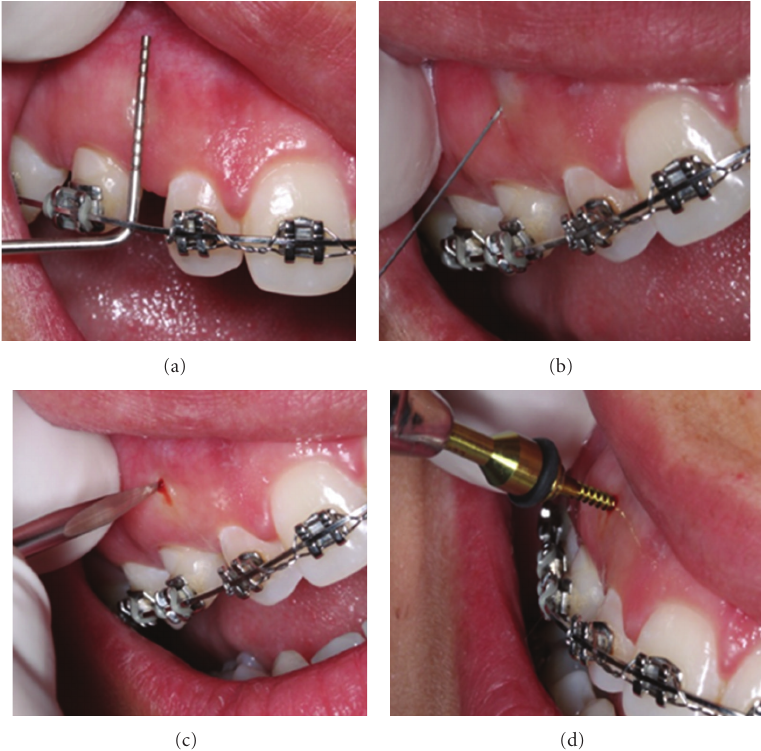
Figure 4: Self-drilling orthodontic implant procedure: (a) marking the space between adjacent roots; (b) punch soft tissue anesthesia; (c) pilot drilling with a lance (d) perpendicular insertion of OI without lateral movements or excessive